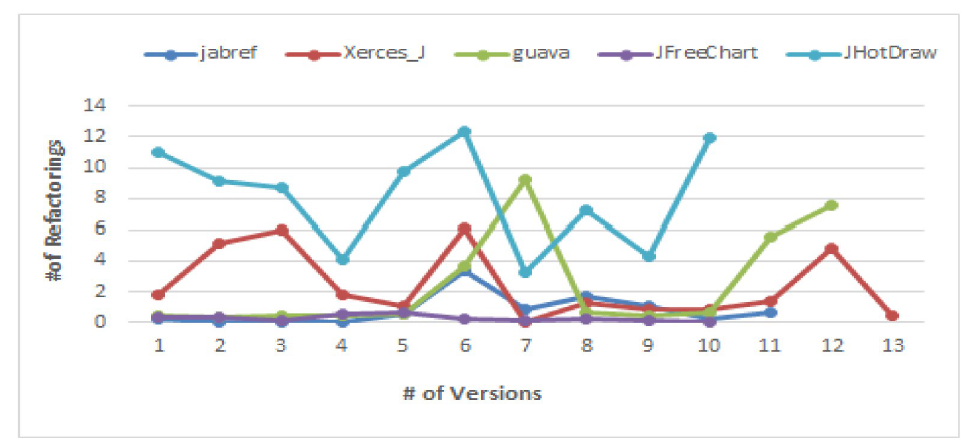
Fig 6. Clone refactoring ratio in versions of five Java